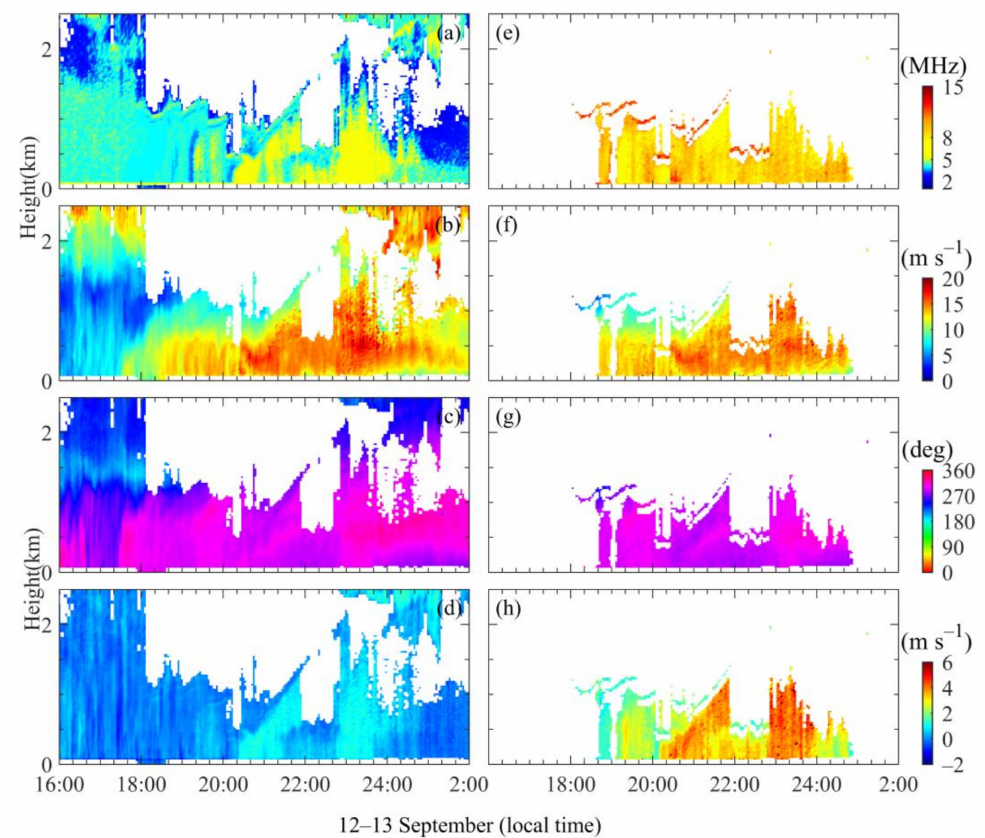
Figure 7. ( a ) The spectrum width of aerosol and cluster C; ( b ) horizontal speed of aerosol and cluster C; ( c ) horizontal direction of aerosol and cluster C; ( d ) vertical velocity of aerosol and cluster C; ( e ) the spectrum width of raindrop and cluster D; ( f ) horizontal speed of raindrop and cluster D; ( g ) horizontal rain direction of raindrop and cluster D; ( h ) vertical velocity of raindrop and cluster